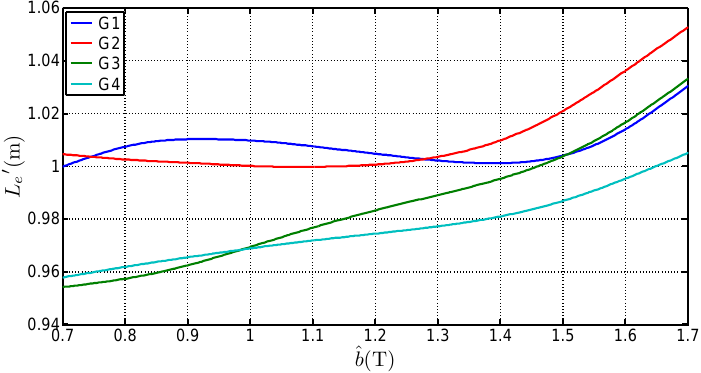
Figure 12. Variations of L (cid:48) e with ˆ b for four steel grades.